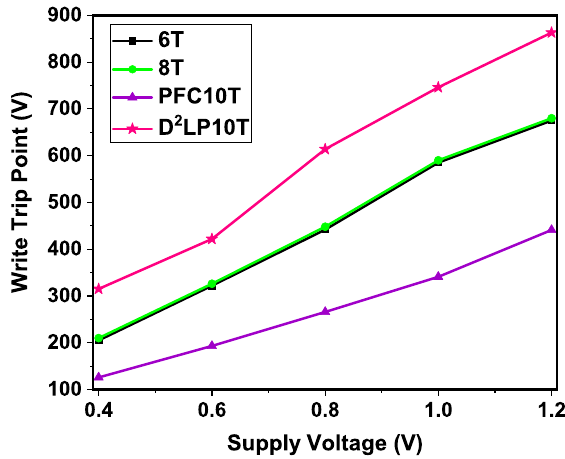
Figure 10. Write trip point of different SRAM cells at different supply voltages.